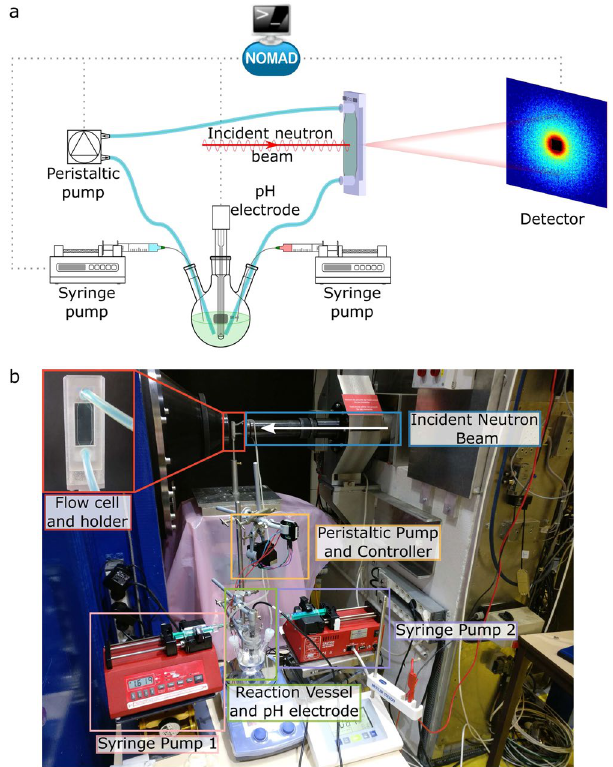
Figure 2. ( a ) Schematic of experimental set-up with dotted lines representing data connections. ( b ) Photograph of the experimental set-up on the D11 instrument. The NOMAD icons in ( a ) are used with permission from the Institut Laue-Langevin, the publisher and rights holder of the NOMAD instrument control software.